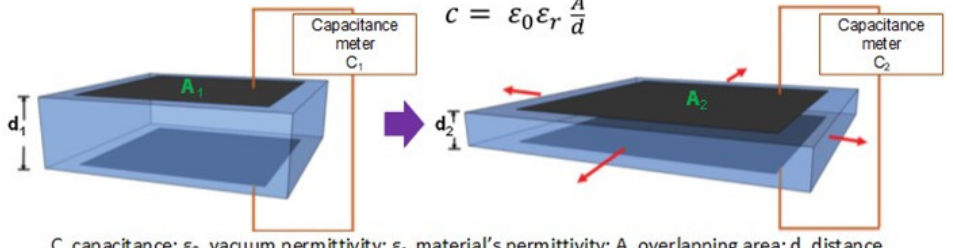
Figure 6. Illustration of electromechanical sensing mechanism for DE [4]. Open access, Copyright Royal Society Publishing.